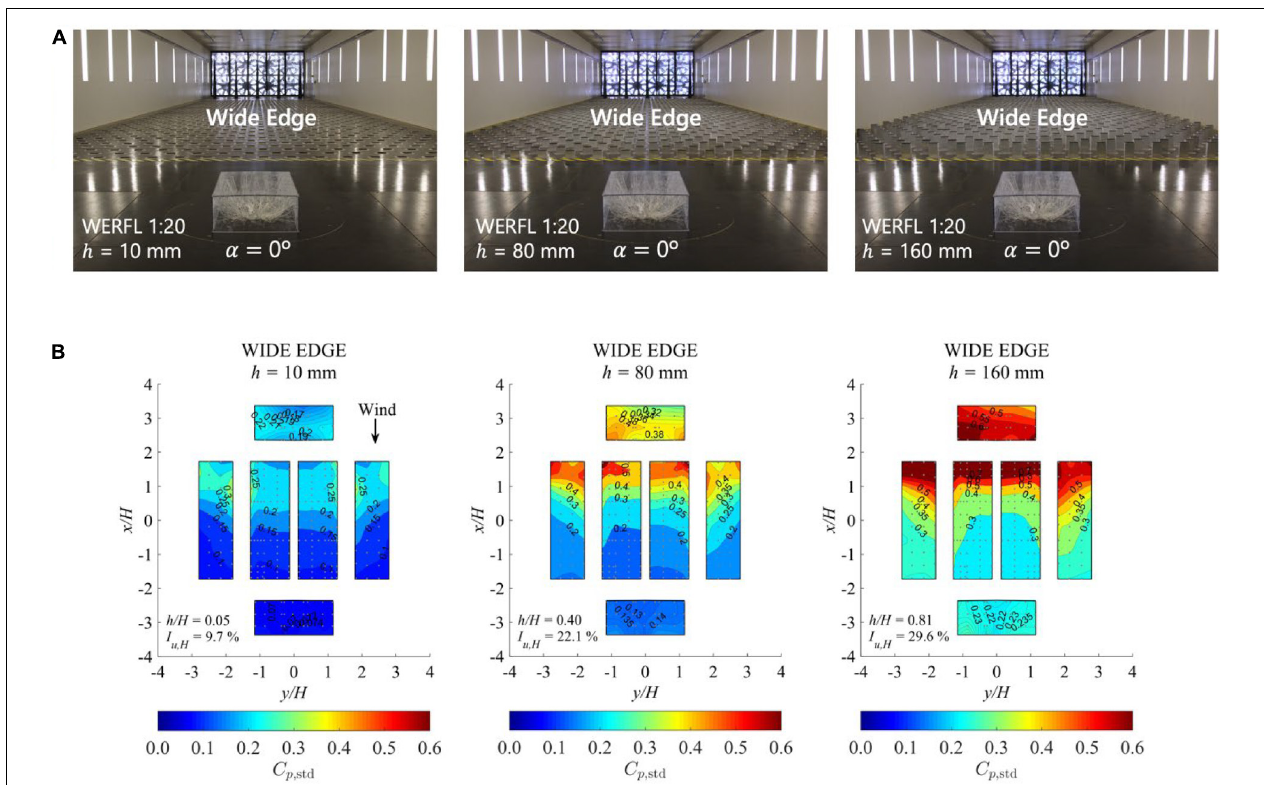
FIGURE 6 | (A) Aerodynamic BLWT tests on the 1:20 WERFL model for three homogeneous Terraformer configurations ( h = 10, 80, and 160 mm); (B) pressure coefficient contours of standard deviation (from Fernández-Cabán and Masters, 2018a under the Creative Commons CC BY